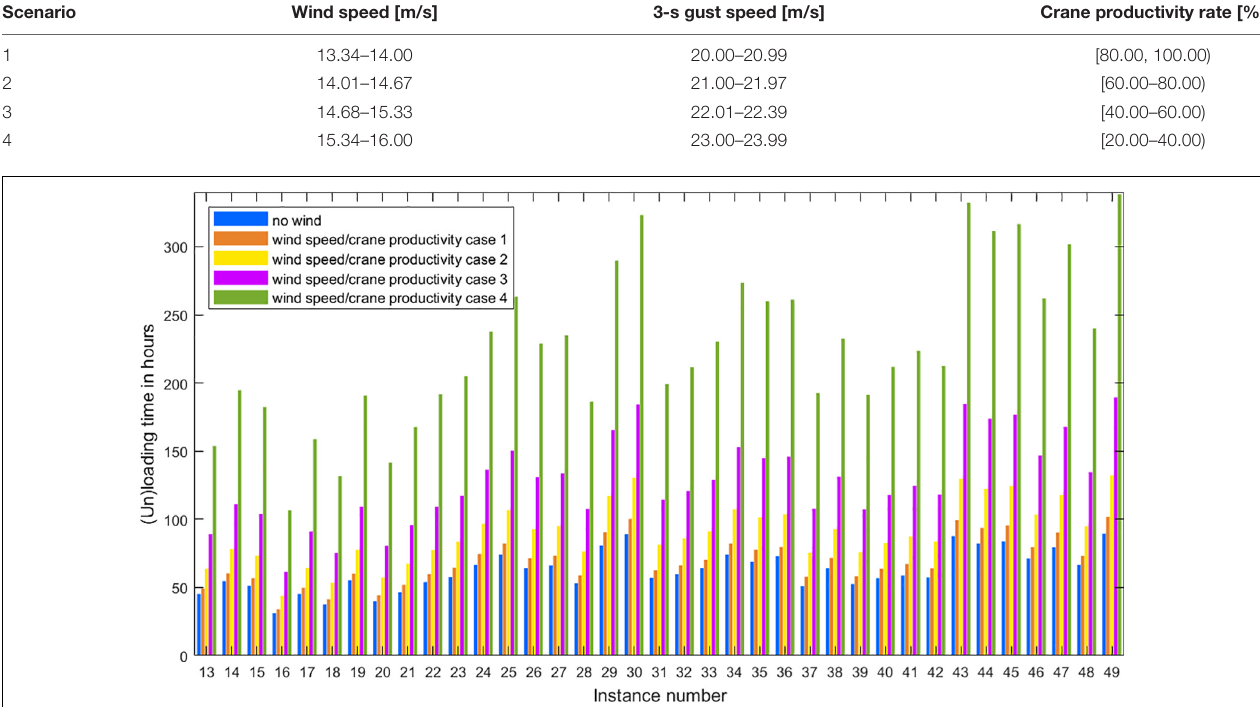
TABLE 11 | Characteristics of the considered wind speed/crane productivity scenarios.